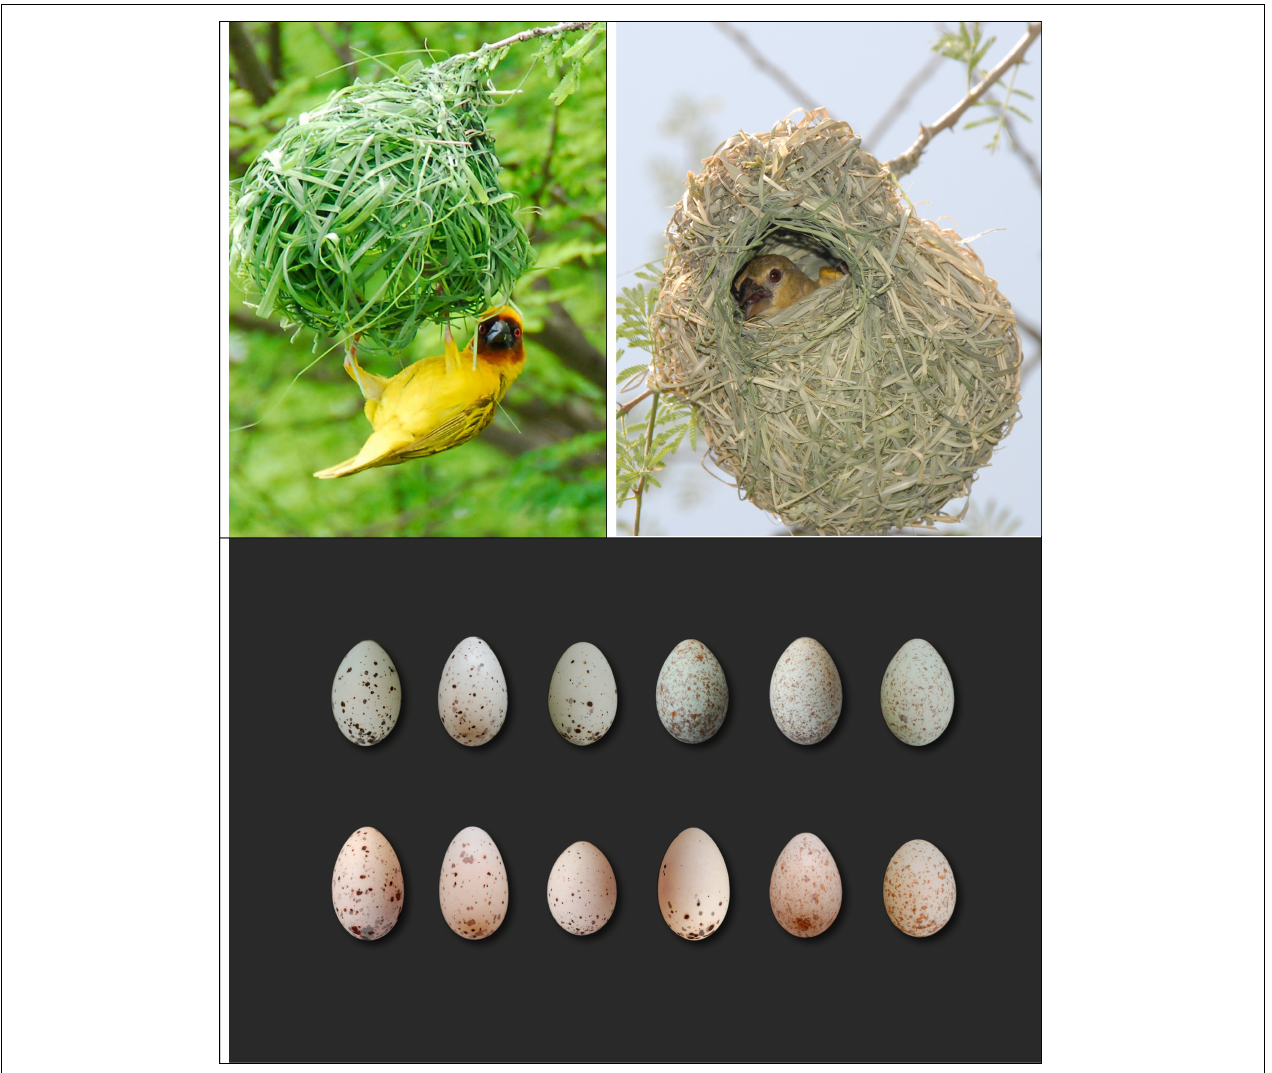
FIGURE 1 | Rüppell’s weaver ( Ploceus galbula ). Top left : a male at the nest; top right : a female inside the nest. Bottom : sample eggs, each laid by a different